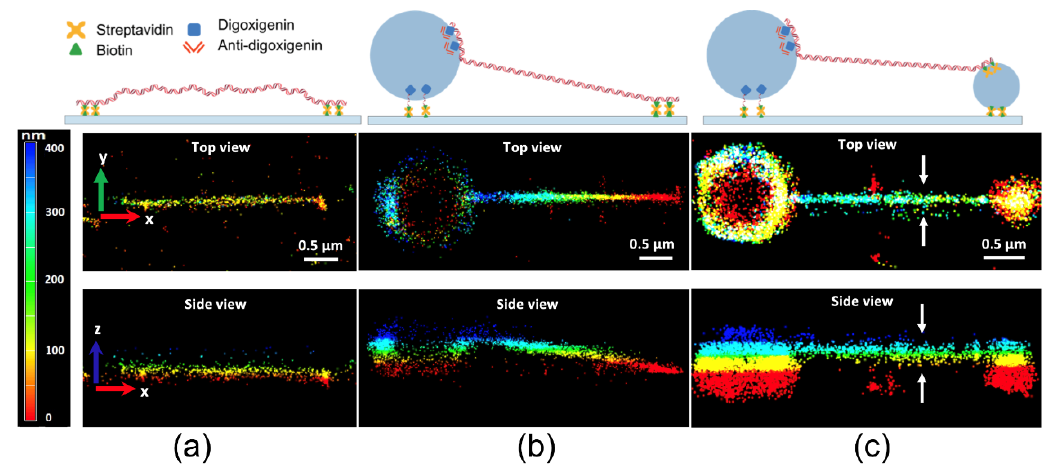
Figure 7. ( a ) Three-dimensional BALM images of 10 kb linear dsDNA tethered to the surface of the glass at both ends, ( b ) tethered to the surface at one end and to a 1 μm diameter bead at the other end, and ( c ) tethered to a 1 μm diameter bead at one end and a 0.4 μm diameter bead at the other end. The image was reproduced with permission from Yardimci et al., published by Nature Publishing Group, 2020